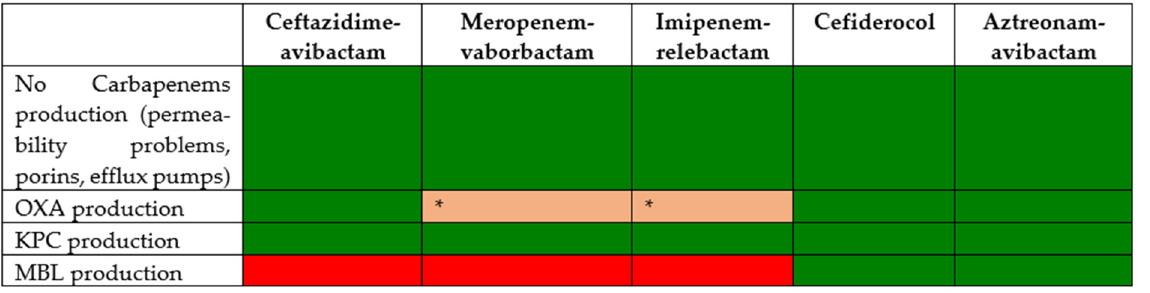
Figure 2. Activity of new antibiotics against Klebsiella pneumoniae resistant to carbapenems, according to resistance mechanisms. Green, susceptible; red, resistant. * Despite the fact that vaborbactam and relebactam are not able to inhibit OXA-48, both imipenem and meropenem have activity against some